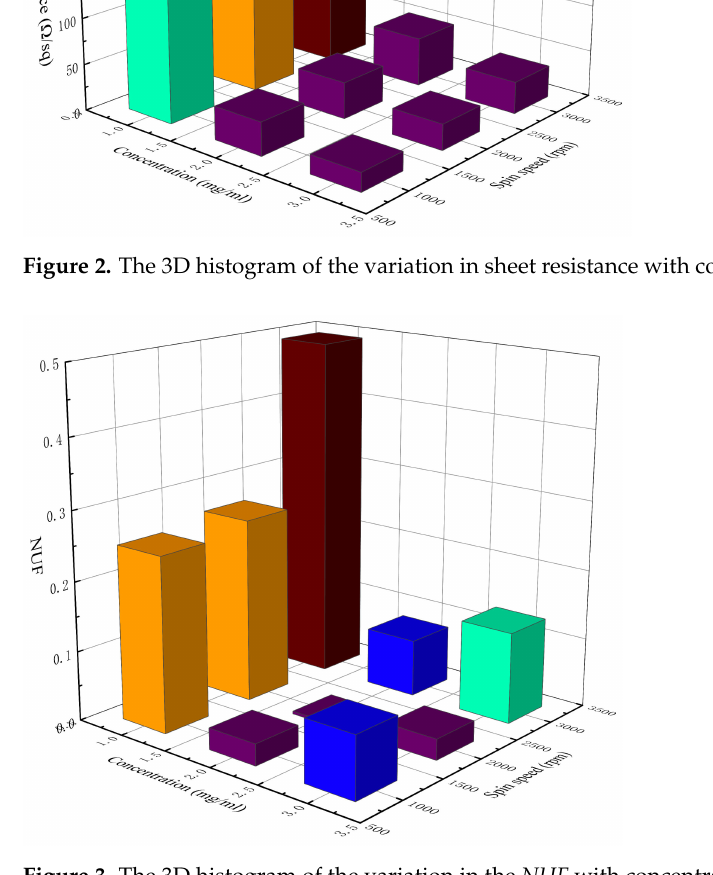
Figure 3. The 3D histogram of the variation in the NUF with concentration and spin